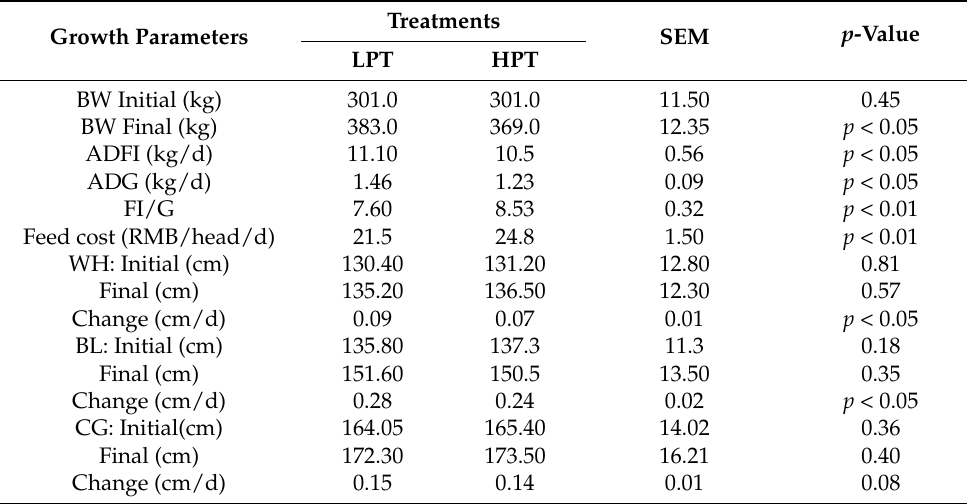
Table 3. Effects of low and high NFC to NDF ratio pelleted TMR on growth performance parameters in Holstein growing cattle.